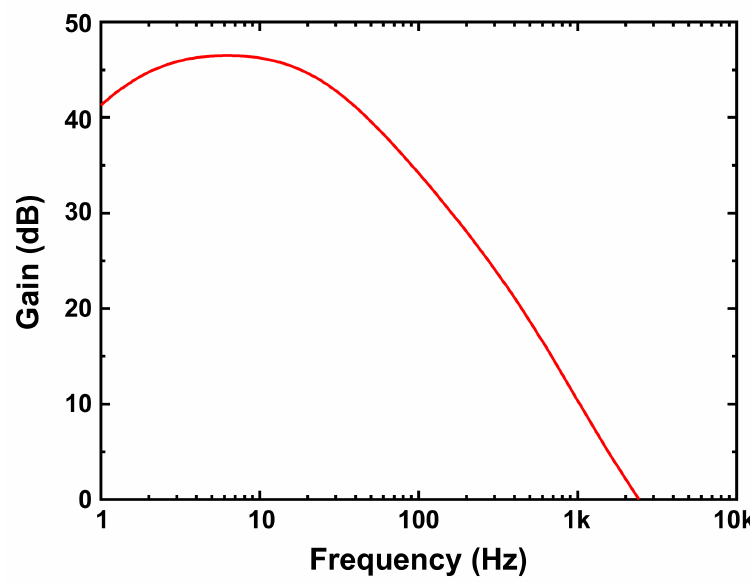
Figure 5. AC characteristics of the front-end amplifier shown in Figure